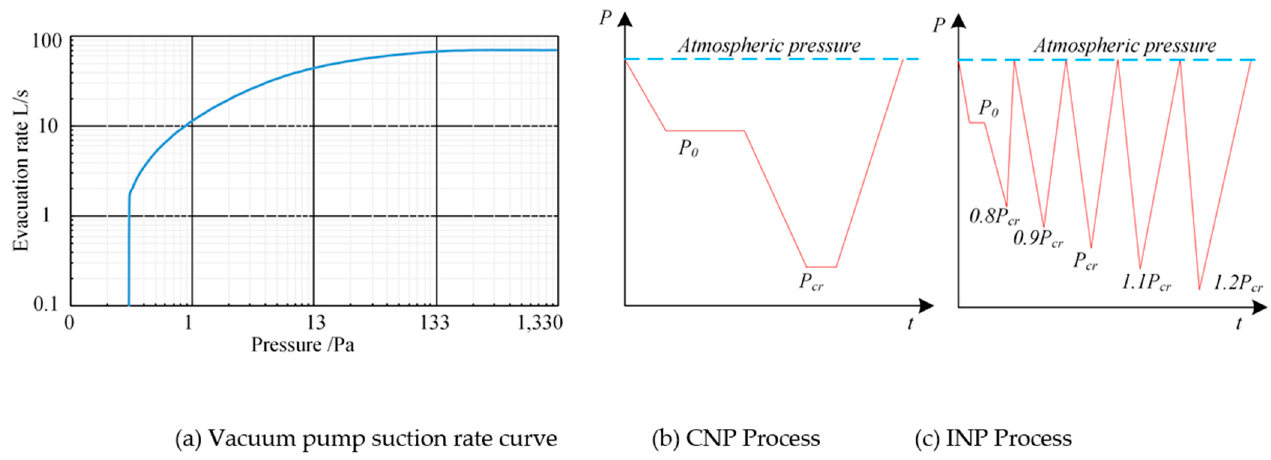
Figure 4. Loading process. Figure 4. Loading